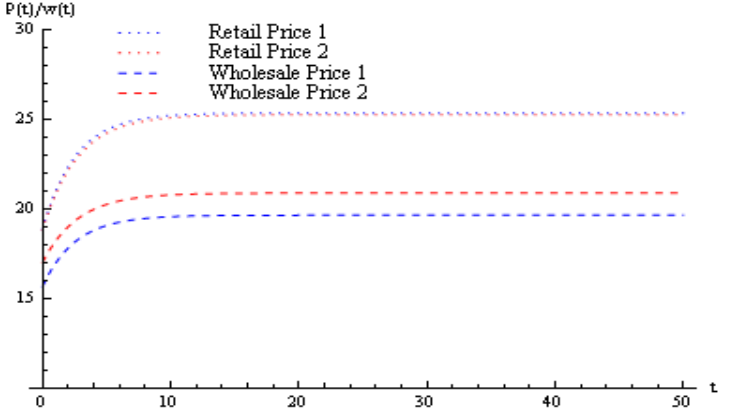
Figure 2. Product optimal price curve over time, under decentralized decision making.